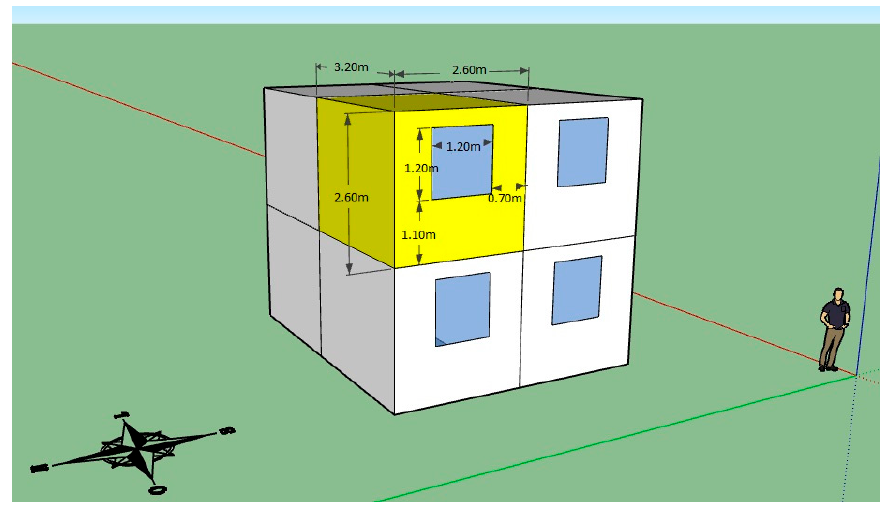
Figure 3. Reference model used in numerical simulations. Table 9. External wall systems (EWS) considered in numerical